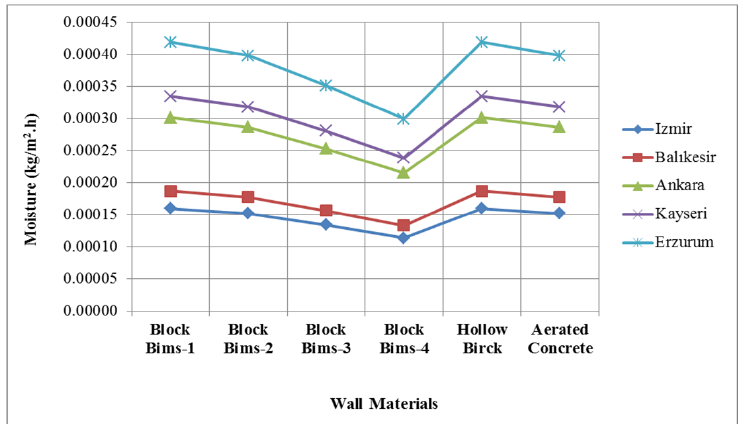
Figure 12. Moisture values due to different wall materials for uninsulated wall.